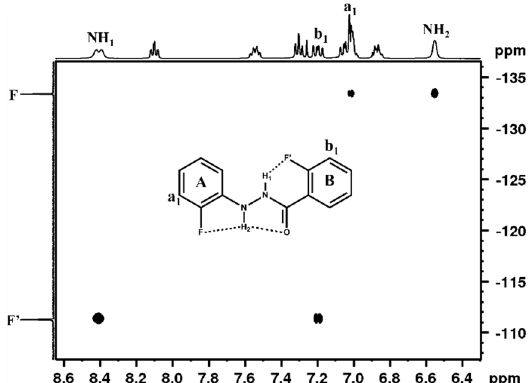
Figure 20. 400 MHz two dimensional 1 H- 19 F HOESY spectrum of molecule 20 . The detection of strong cross peaks convincingly established the correlations between NH (1) proton and F and also NH (2) proton and F. The cross peaks were also observed for phenyl protons a 1 and b 1 . The mixing time used in the experiment was 450 ms.